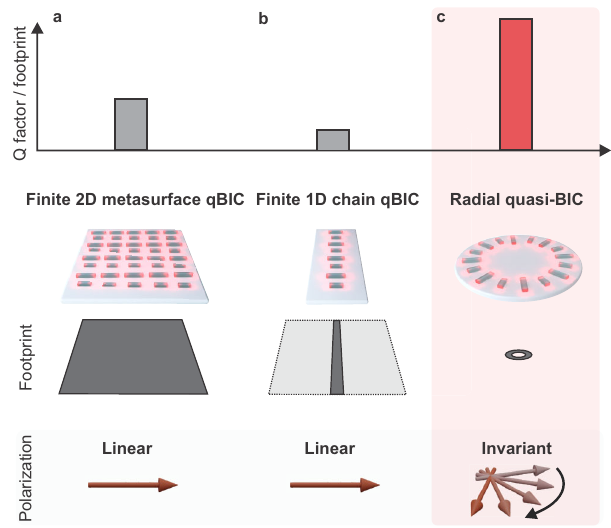
Fig. 1 | Conceptual advantages of radial quasi-bound states in the continuum (radial BICs). Established symmetry-broken quasi-BIC geometries, such as 2D metasurfaces ( a ), and 1D chains ( b ), exhibit large footprints, moderately high Q factors, and require polarization-dependent excitation. The radial BIC concept ( c ) combines a tiny footprint with high-Q factorsinthe visible.Above all, the radial BICplatformprovidesthehighestQfactorperfootprintratiocomparedtoother1D and 2D BIC-based platforms, as shown